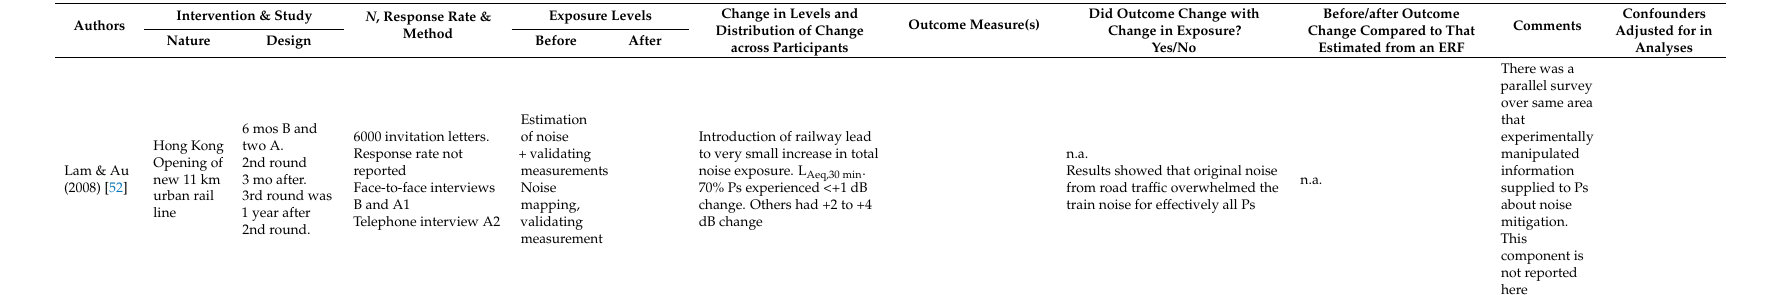
Table 17. New/Closed Infrastructure (Type C).